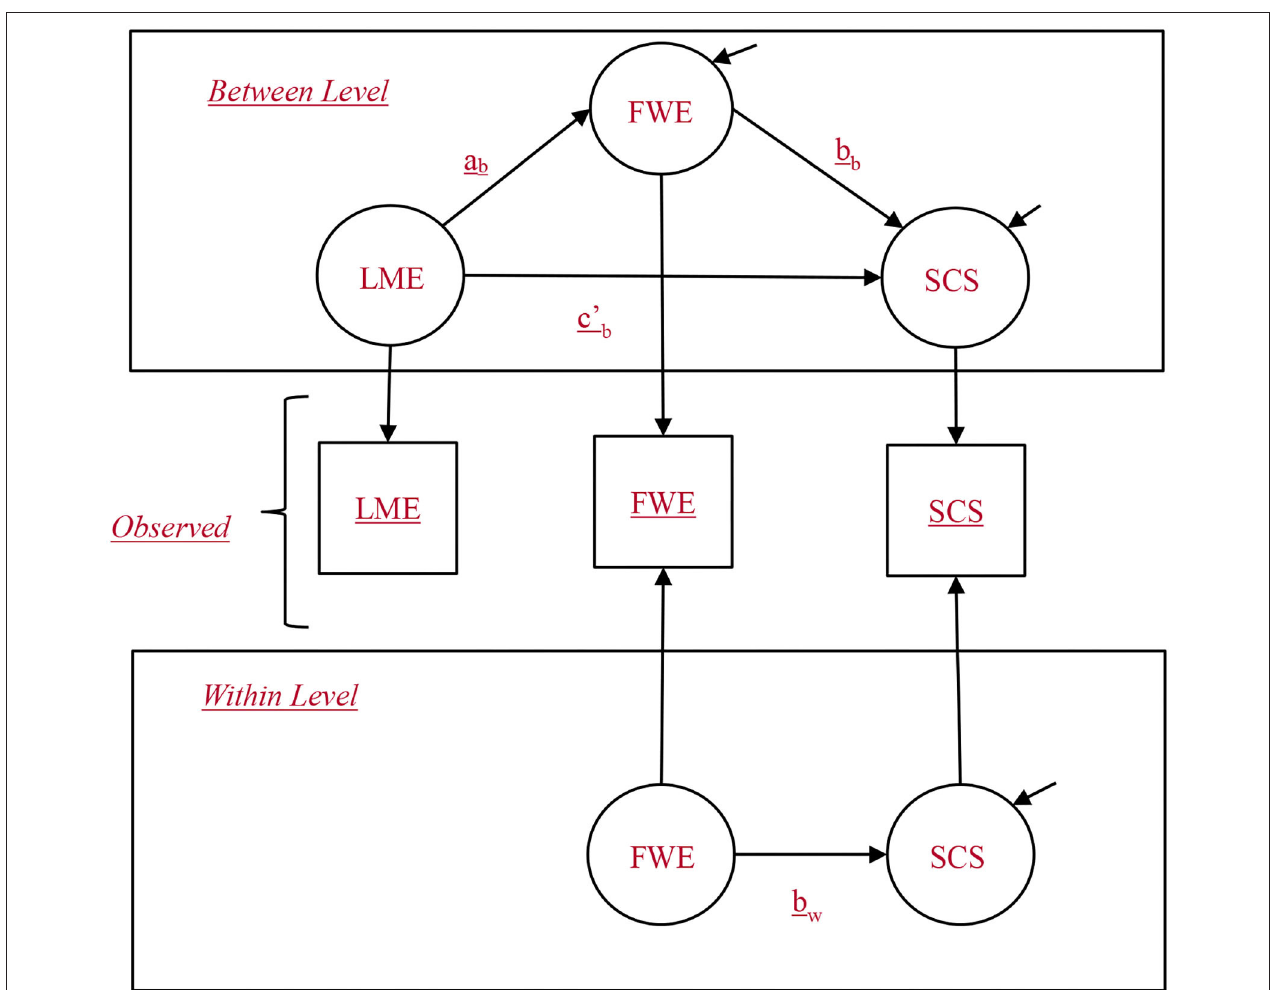
FIGURE 1 | Multilevel structural equation model for the 2-1-1 hypothesized model. SCS, subjective career success; LWE, leaders’ work engagement; FWE, followers’ work engagement. b subscript represents between level and w subscript represents within level.